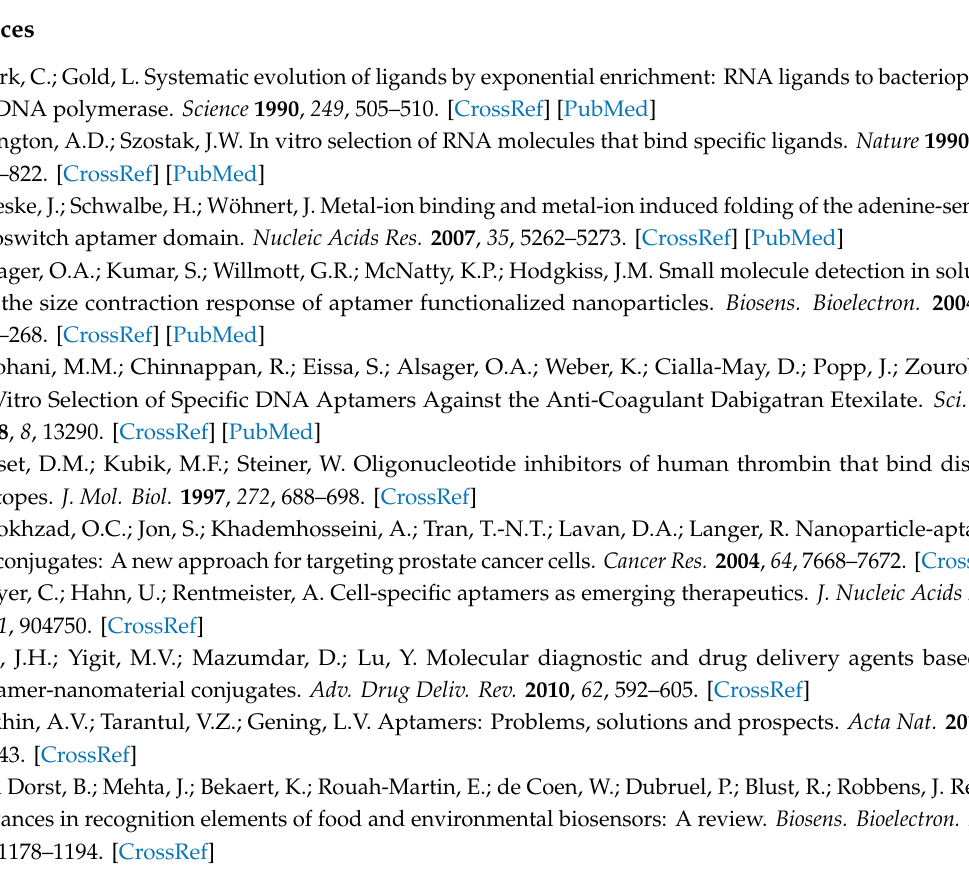
Figure S1: secondary structures of VTD3 and BPA aptamers, Table S1: sequences used in this study, Figure S2: interaction of SYBER Green I and curcumin molecules with duplexed strand of the VTD3 aptamer, Figure S3: fluorescent signals and CD measurements of VTD3 sensor based on SYBER Green I, and Figure S4: fluorescent spectra of VTD3 detection in extracted blood